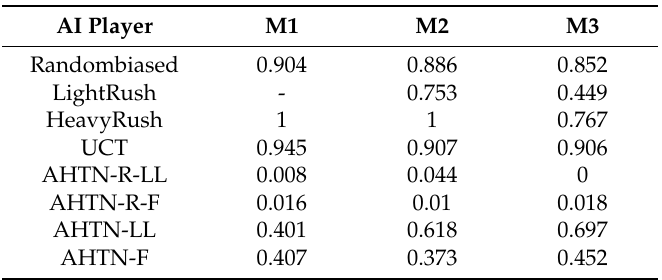
Table 4. Average repair rate of AHTN-R-F against the 8 algorithms for the three map sizes. The symbol “-” indicates no failed tasks. AI Player